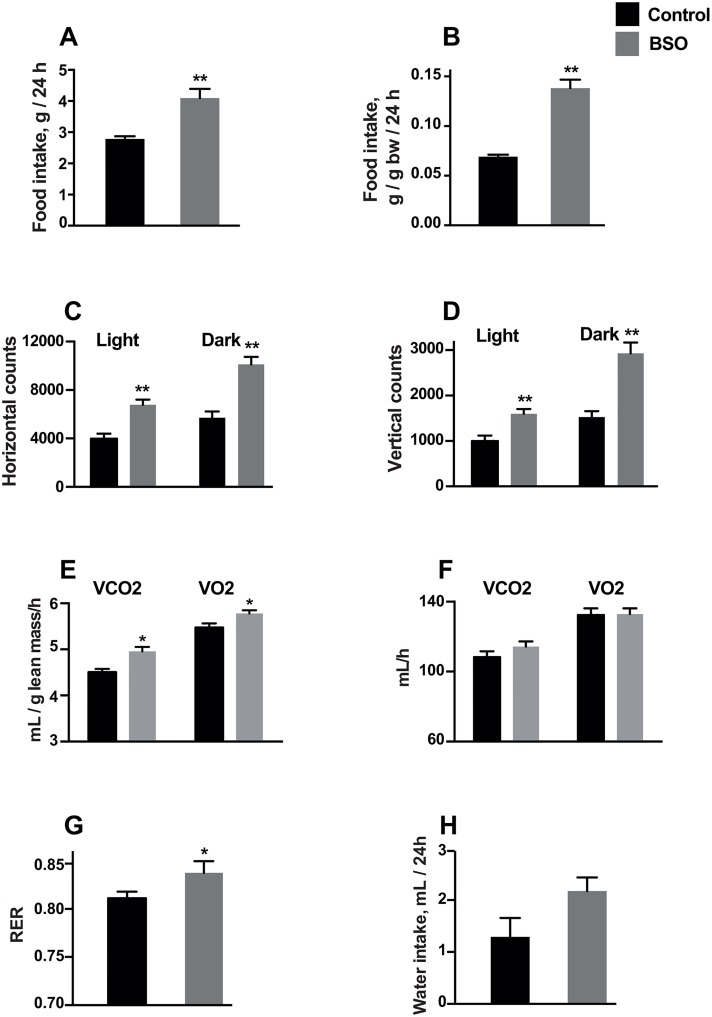
Phenomaster cage data at week 2 in BSO-treated and control mice.A, B: Food intake in g/day, and food intake normalized to body weight. C, D: Physical activity measured as infrared beam breaks in the horizontal and vertical planes during the light and dark phases of a 24-h period. E: O2 consumption (VO2)/lean mass ratio and CO2 production (VCO2)/ lean mass ratio. F: Adjusted mean VO2 and VCO2 controlling for lean mass as a covariate (at a common lean mass of 23.6 g) using general linear modelling. G: Respiratory exchange ratio (RER). H: Water intake in the studied groups. Data is presented as mean ± SEM and compared by independent samples T-test. N = 16–18 (control) and N = 17–20 (BSO). *, ** P<0.05 and P<0.001 respectively vs controls.